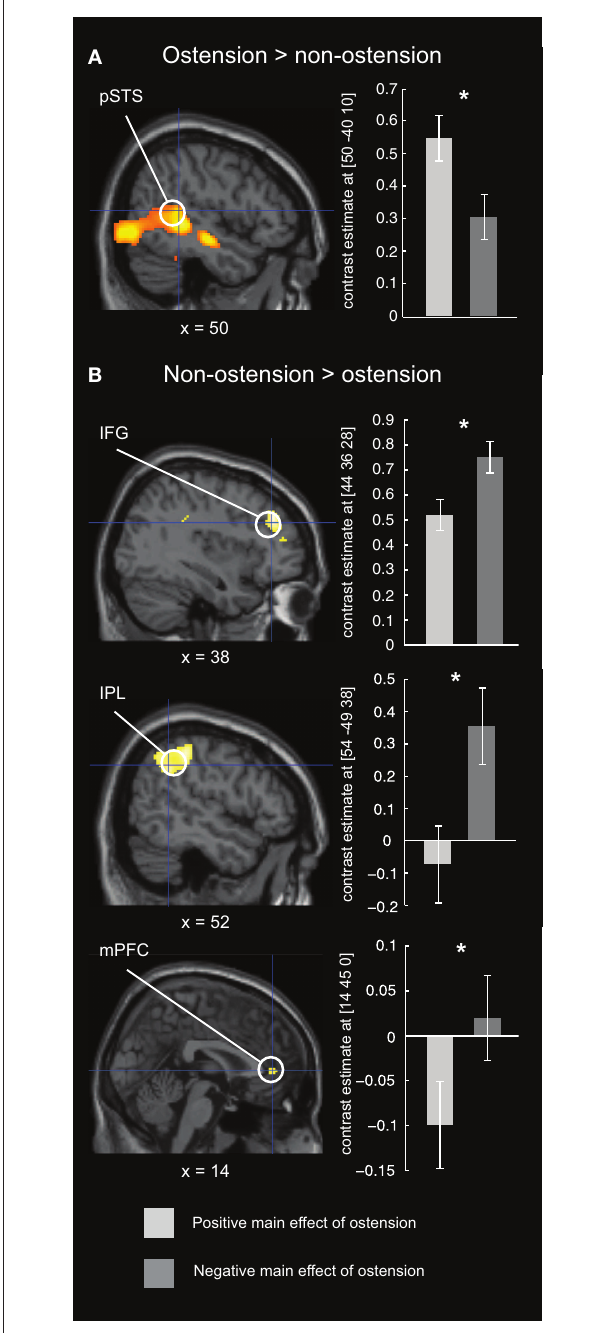
FIGURE 4 | Results of the fMRI ROI analysis for the ostensive condition. Left column: brain maps depicting differential BOLD responses evoked by ostension ( + / − ) in relevant ROIs. Right column: bar plot of peak voxel contrast estimates for the positive and negative main effect of ostension in each of the ROIs. Error bars express 90% confidence intervals. (A) in the positive main effect of ostension, higher BOLD responses were found in rpSTS, an area related to fine temporal integration and adaptation (e.g., in the context of joint action). (B) in the negative main effect of ostension, higher BOLD responses were found in rIFG and rIPL, areas often associated with the mirror neuron system, and in the mPFC, often associated with theory of mind/mentalizing. ∗ p < 0 . 05 (FWE-corrected).